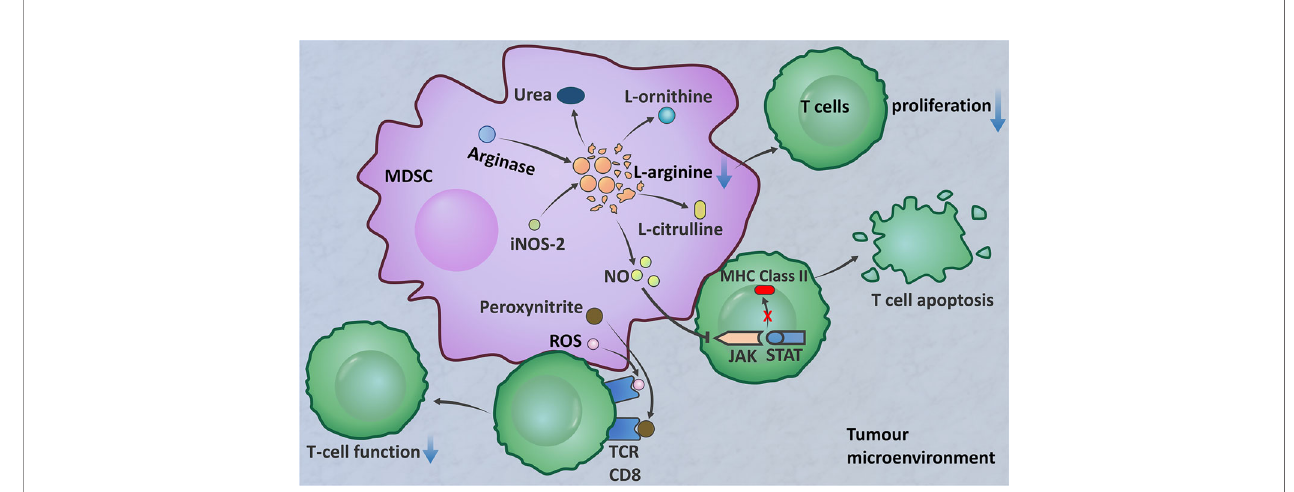
FIGURE 2 | The immunosuppressive function of MDSCs. MDSCs produce arginase, which decomposes l-arginine into urea and l-ornithine (163, 164). MDSCs express iNOS2, which converts l-arginine into NO and l-citrulline (165). L-Arginine de fi ciency inhibits T cell proliferation. NO interferes with JAK/STAT signalling proteins, inhibits the transcription of MHC class II genes, and induces T cell apoptosis (166 – 168). MDSCs produce high levels of peroxynitrite and ROS when in direct contact with T cells to induce TCR and CD8 molecular modi fi cation, resulting in CD8 + T cells losing the ability to bind to the pMHC complex; this results in nonresponse of peripheral blood tumour-speci fi c CD8 + T cells